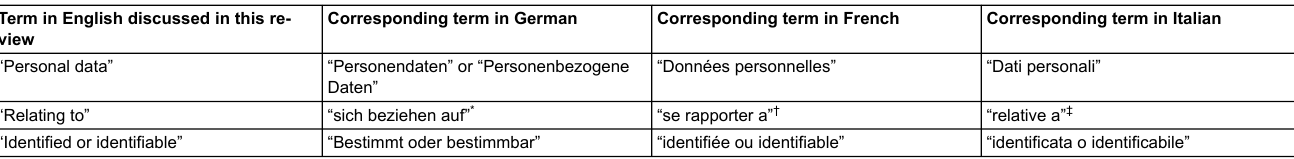
Table 1: Cross-language comparison for Switzerland of the legal terminology discussed as part of the first node. Term in English discussed in this re-